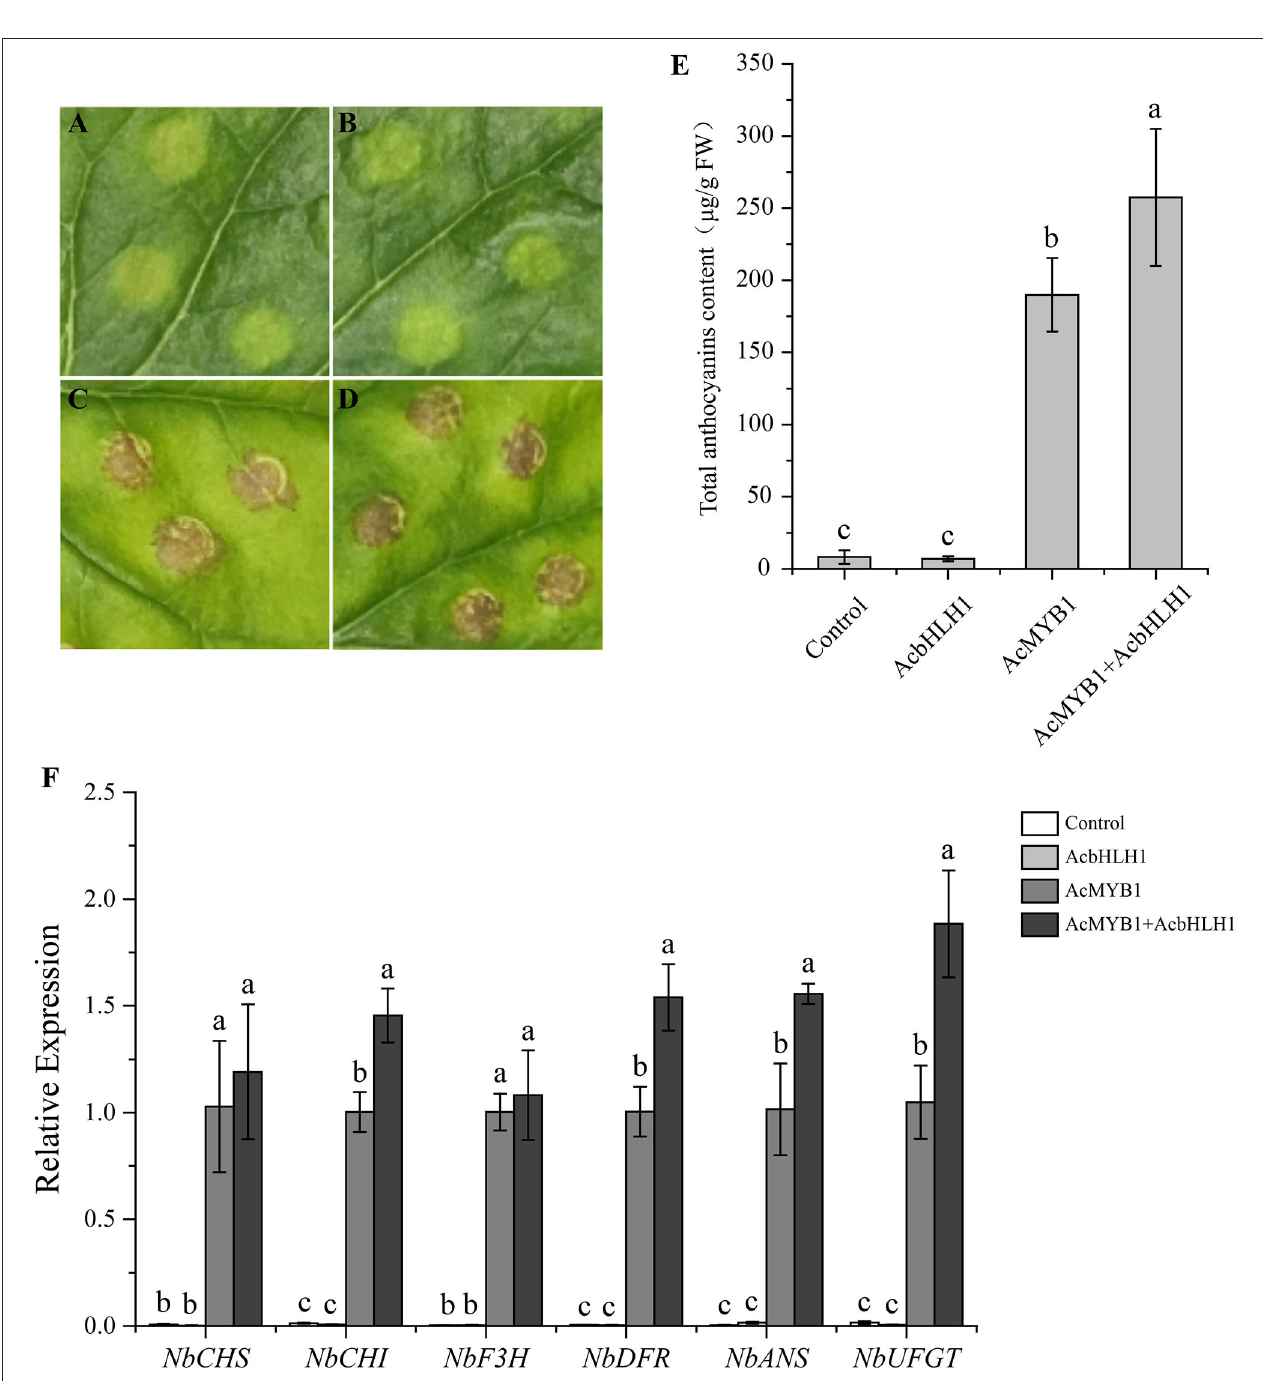
FIGURE 8 | Transient over-expression assay in N. benthamiana leaves. Images of infiltration sites 8 days after transformation of control vector (A) , AcbHLH1 (B) , AcMYB1 (C) , and AcMYB1 + AcbHLH1 (D) . (E) The anthocyanin content of N. benthamiana leaves after infiltration. (F) The expression analysis of six anthocyanin biosynthetic genes of N. benthamiana after infiltration. The relative expression was calculated based on the 2 − 11 CT method using the NbActin gene as the reference gene.